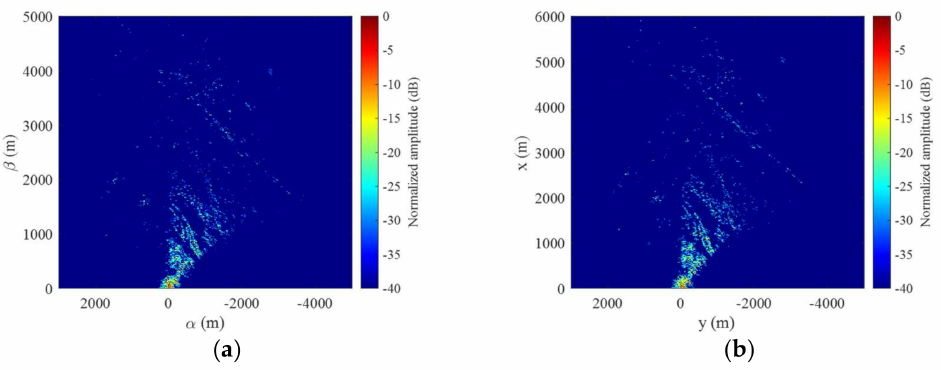
Figure 15. MF-PB-SAR images of the urban area in Paris ( a ) on the α -o- β plane and ( b ) on the x-o-y plane, obtained by the 2D FISTA-based imaging method.